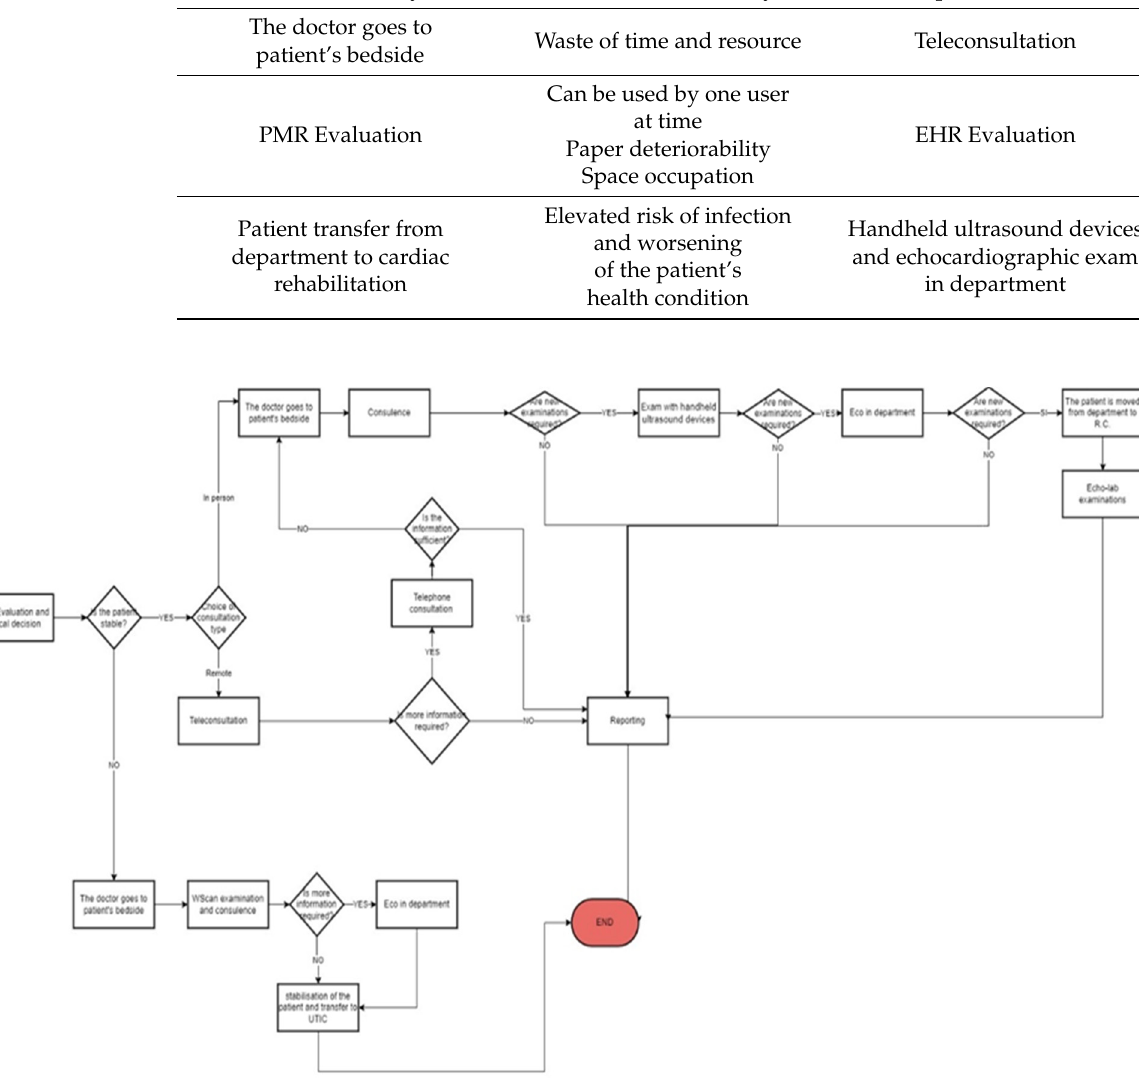
( b ) Figure 4. Process flow chart: ( a ) before Lean intervention; ( b ) after Lean intervention. The X-axis shows the numbers of consultations. The Y-axis shows the time to complete consultation. Average waiting time for consultations is reported in red (solid line).